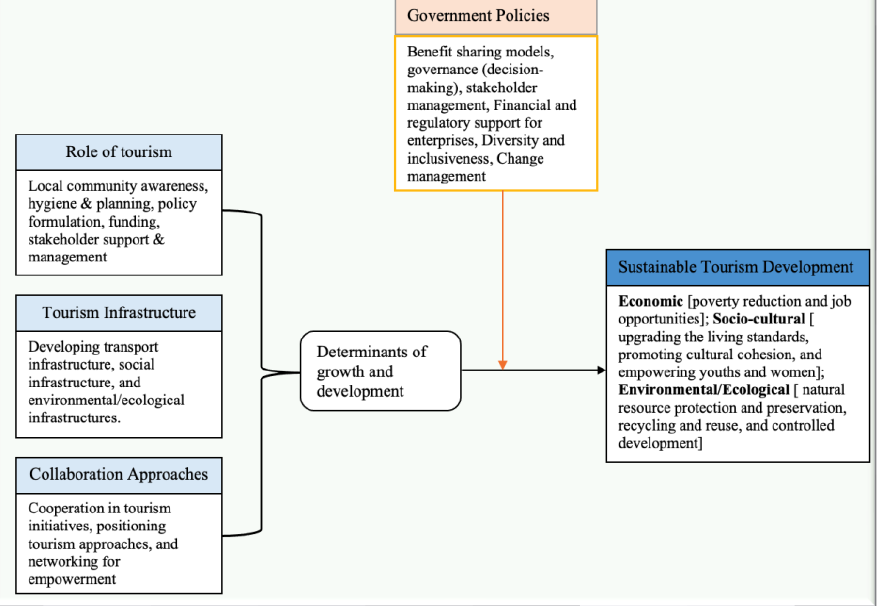
Figure 1: Proposed Conceptual Framework of Sustainable Tourism Development; Source: Authors’